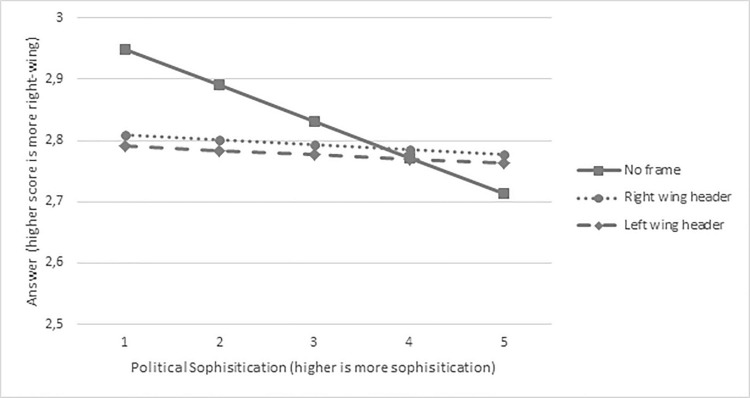
Visualization of the effect of framing on the answers for VAA users with lower and higher levels of political sophistication.The scale for political sophistication has been recoded to range from 1 (low) to 5 (high)).